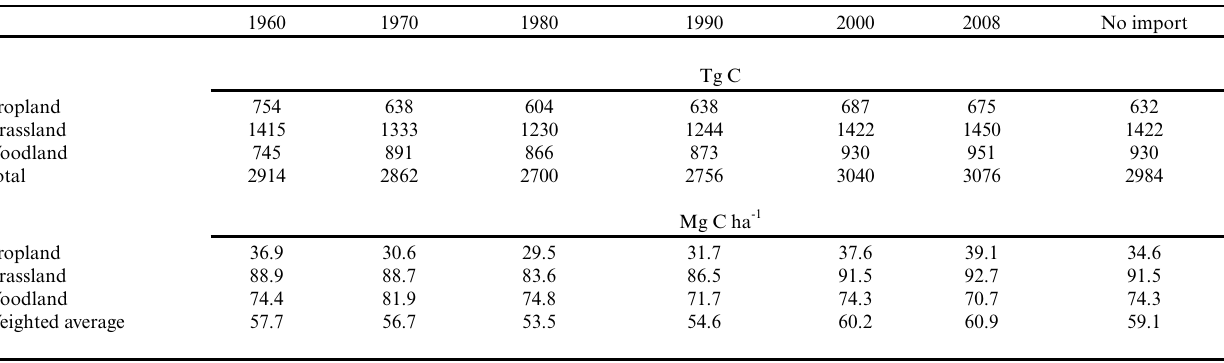
Table 3 . Soil organic carbon stocks at equilibrium for the different land uses and for the whole Spanish territory, 1960-2008 and no- import scenario.